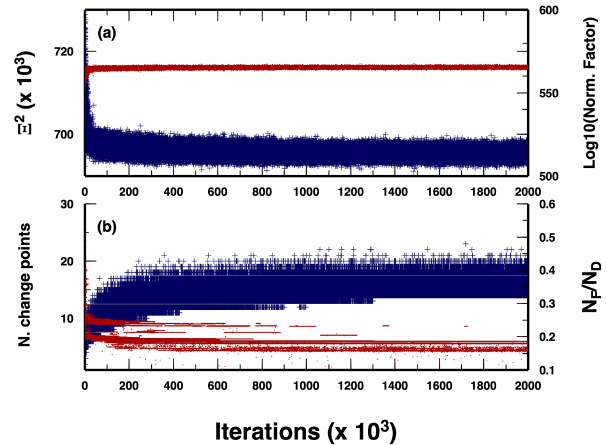
Figure 4. Evolution of some parameters along the McMC sampling. (a) Chi-square value (blue crosses) and logarithmic value of the nor- malizing factor in the likelihood function (red dots). (b) Number of changepoints in the sampled models (blue crosses) and ratio be- tween the number of unaffected data (i.e. DD data for which the two events are not separated by any changepoint) and the total number of DD data, N F /N D (red